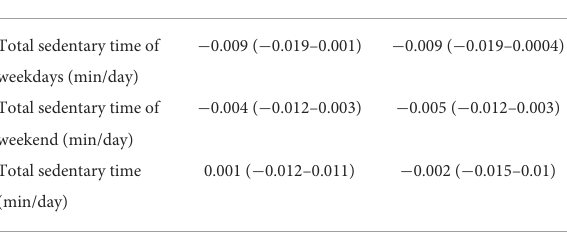
TABLE 2 Associations between objectively-measured total sedentary time and anxiety.